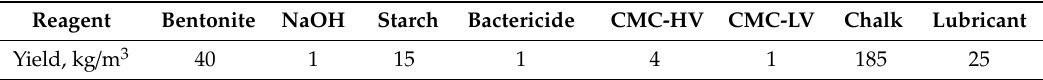
Table 4. Basic composition of polymerbentonite